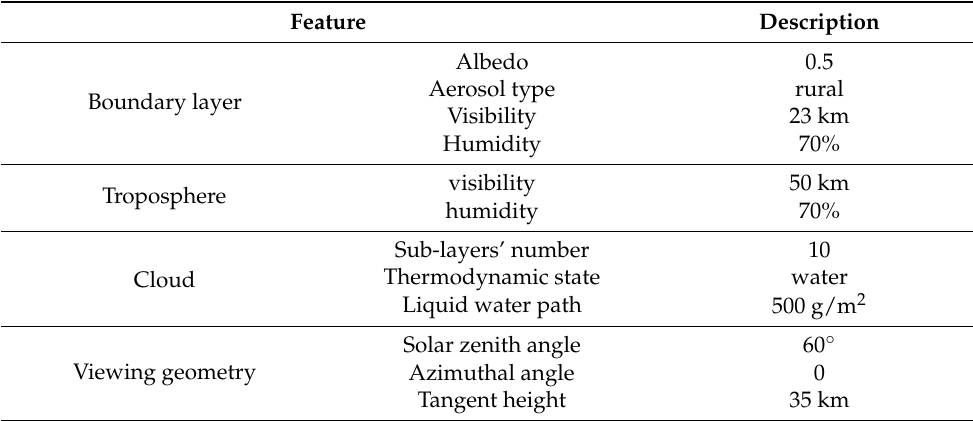
Table 1. Atmospheric conditions for limb atmospheric scattering